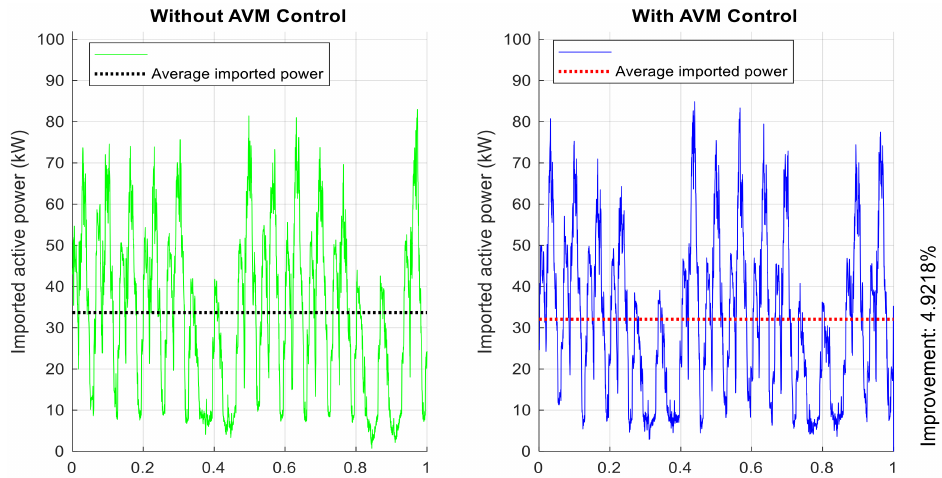
Figure 6. Performance improvement as the result of implementing the AVM algorithm proposed in the RESERVE project for solar photovoltaic array located at ESB Network’s National Training Centre in Portlaoise,